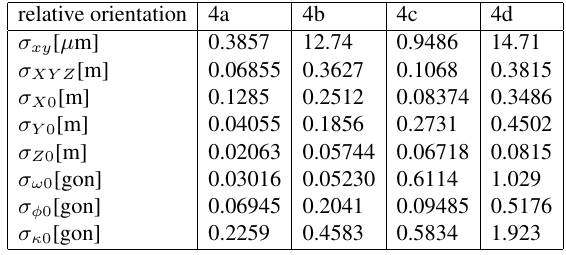
listed in table 2.